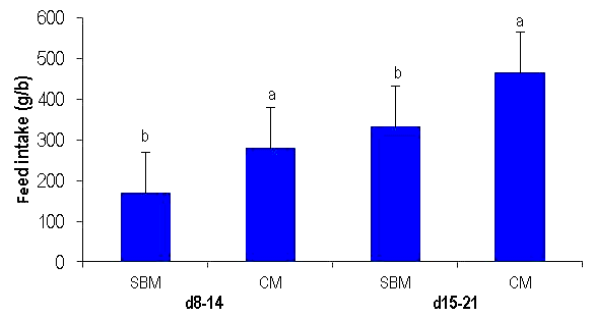
Figure 1. Feed selection by broilers on two VP diets (SBM; CM) from d 8-14, and d 15-21 in choice-fed experiment. VP, vegetable protein; SBM, soybean meal; CM, canola meal. a,b Means bearing uncommon superscript are significantly different at p<0.001 from d 8-14, and at p<0.01 from d 15-21